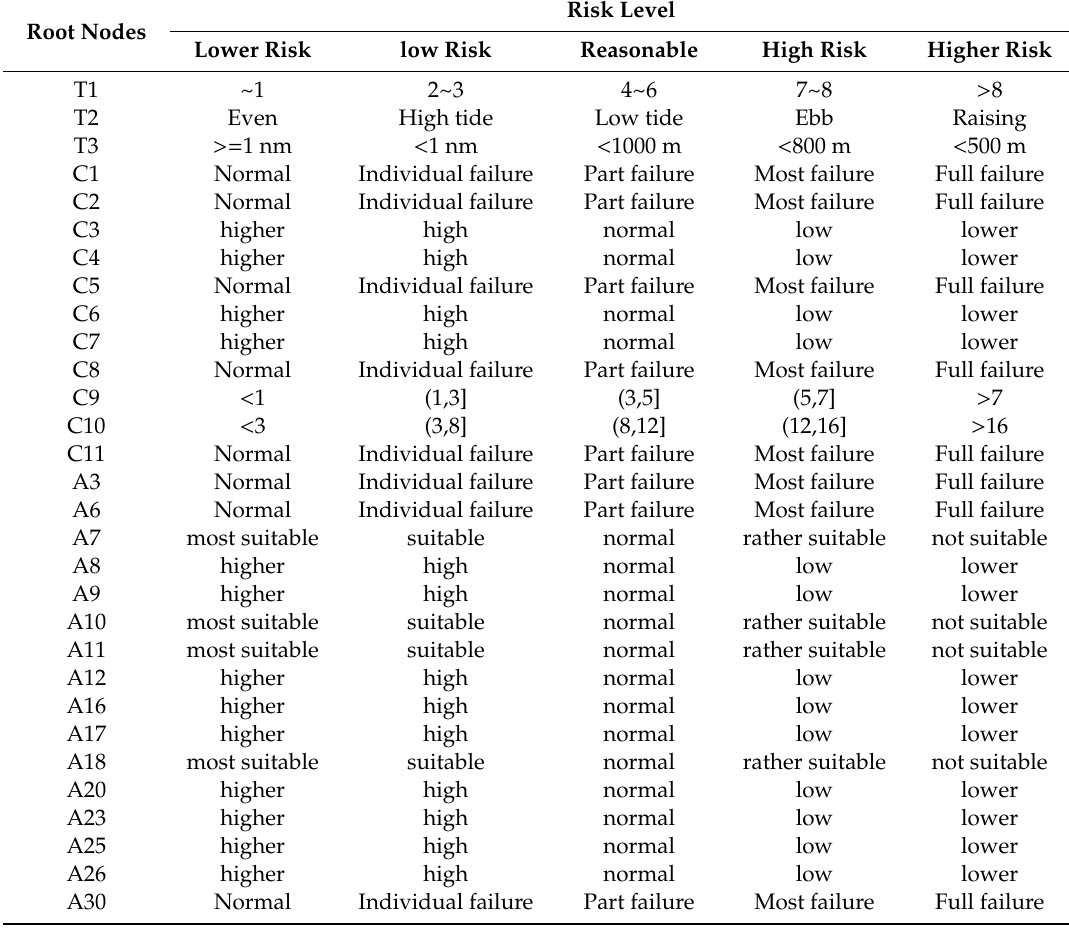
Table 3. Risk assessment standard for root node.